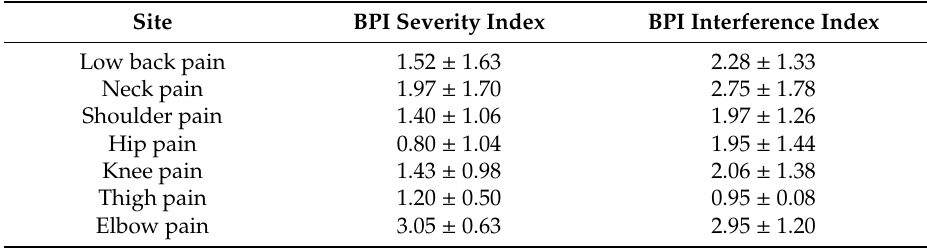
Table 4. Home working-related pain measured with the Brief Pain Inventory (BPI).